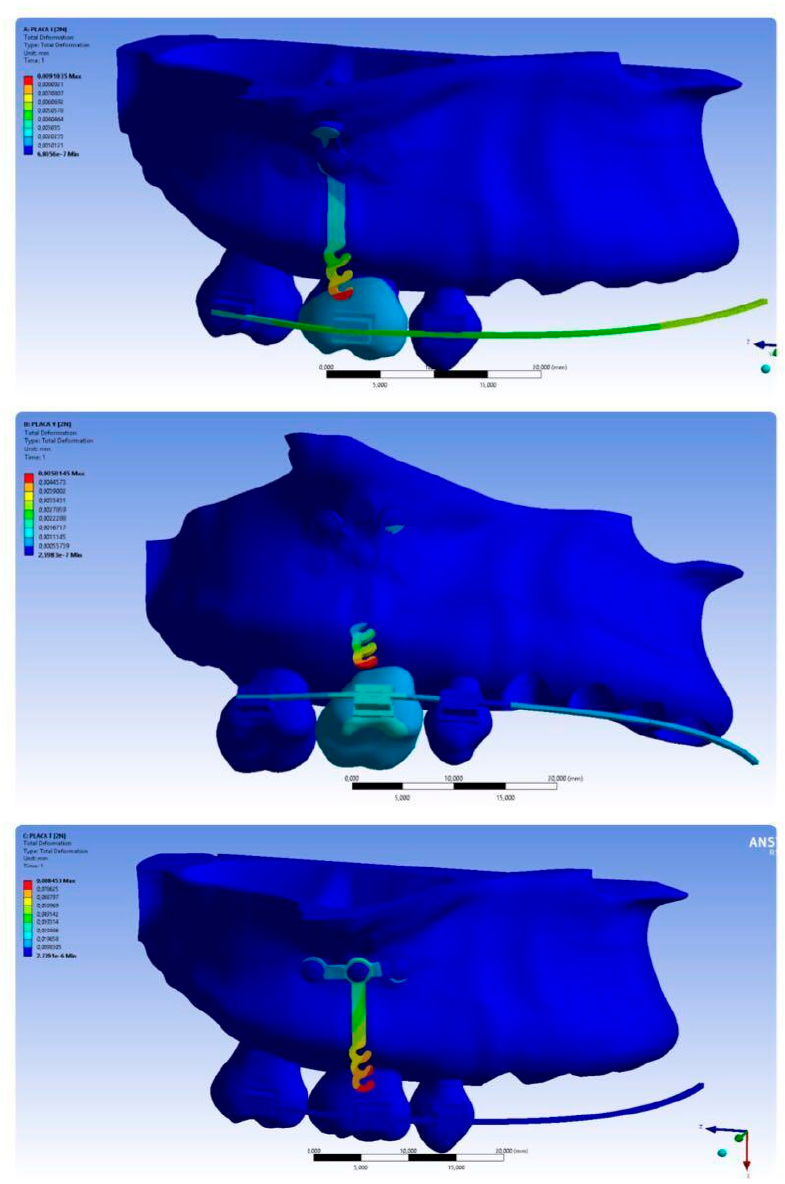
Figure 6. Mesh generated from the three-dimensional model.